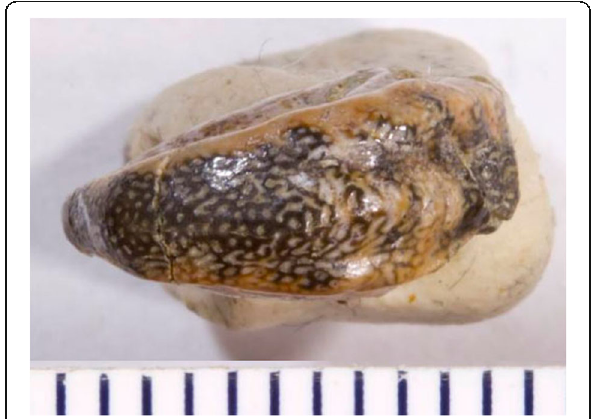
Fig. 6 Occlusal view of holotype of Deltodopsis ? bialveatus St. John and Worthen 1883, USNM V13017. Here designated as Arcuodus bialveatus, comb. nov. Lingual end to right. Millimeter scale divisions.